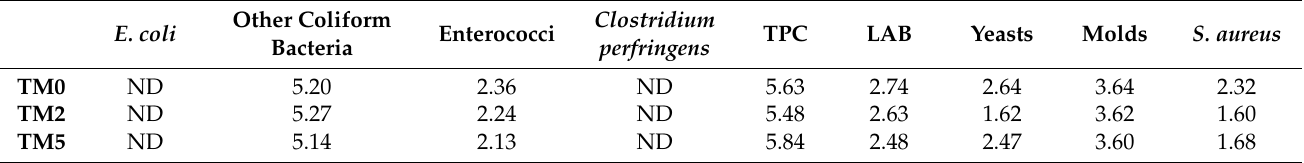
Table 6. Feed microbial analysis at the beginning of the storage period (log CFU).